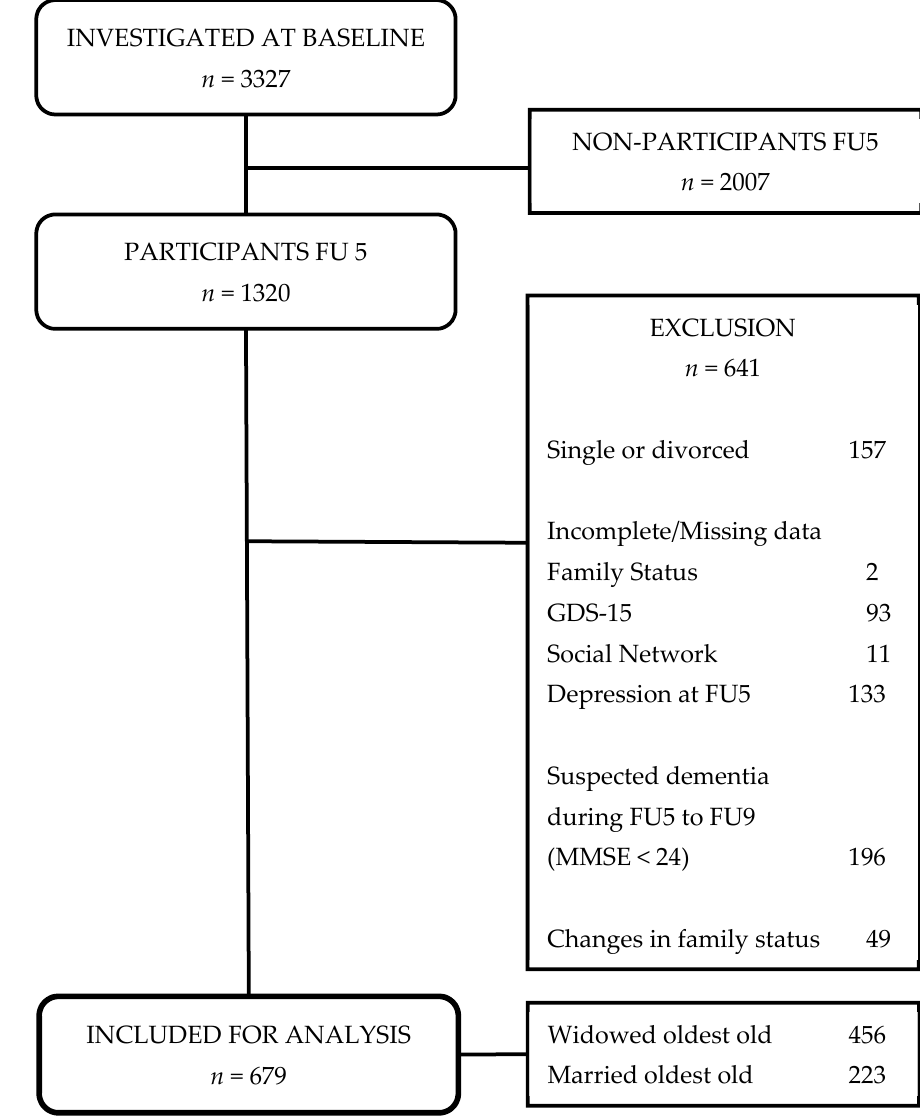
Figure 1. Sampling flowchart of the study. Notes: FU5 = follow-up 5, MMSE = mini-mental status examination.